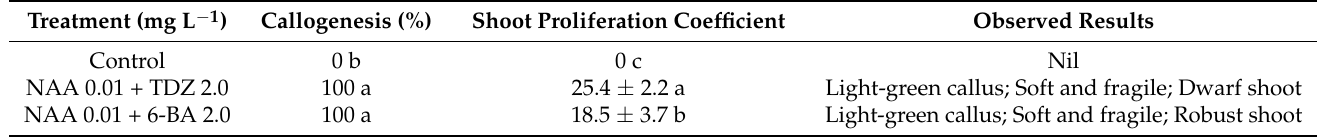
Table 3. Effect of PGRs on induced organogenesis from shoot tip of A. lupulina